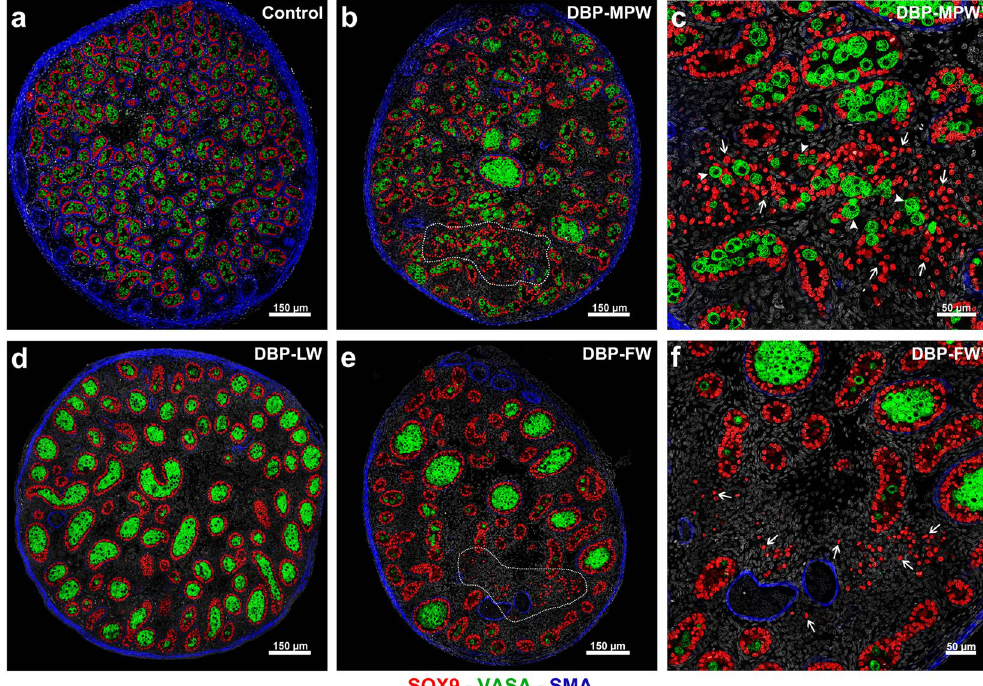
Figure 1. Effect of fetal exposure of rats to DBP during the masculinisation programming window (MPW), the late window (LW) or the full window (FW) on testis histology at e21.5. Sections were triple immunostained for SOX9 (red, Sertoli cells), VASA (green, germ cells), and smooth muscle actin (blue). When present (DBP- MPW and DBP-FW), focal dysgenetic areas are circled by a white dotted line (b, e). Note the presence of ectopic Sertoli (red) and germ (green) cells in the interstitial